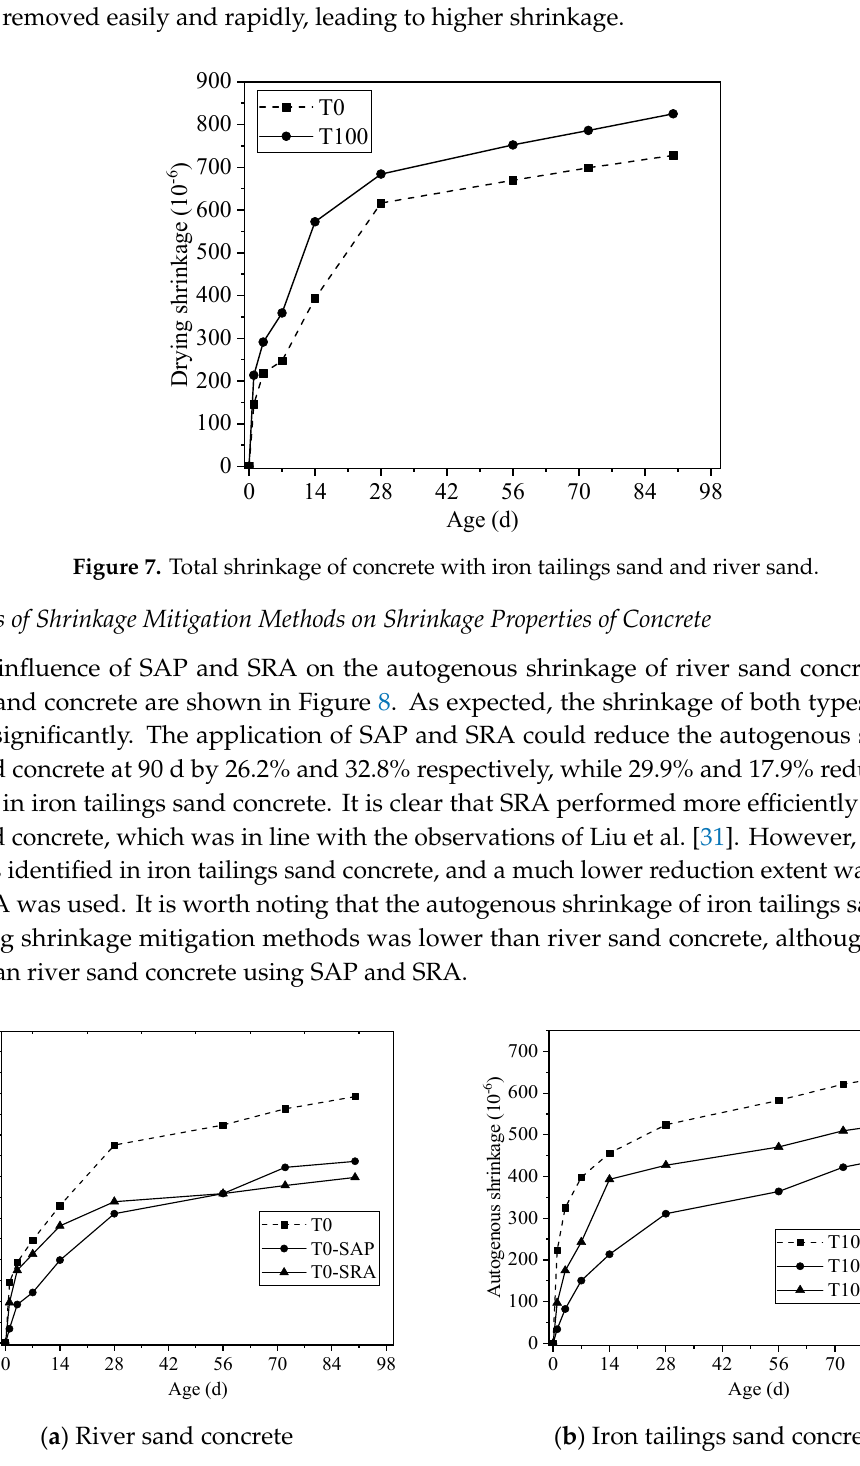
Figure 8. E ff ects of shrinkage mitigation methods on autogenous shrinkage of Figure 8. Effects of shrinkage mitigation methods on autogenous shrinkage of concrete.